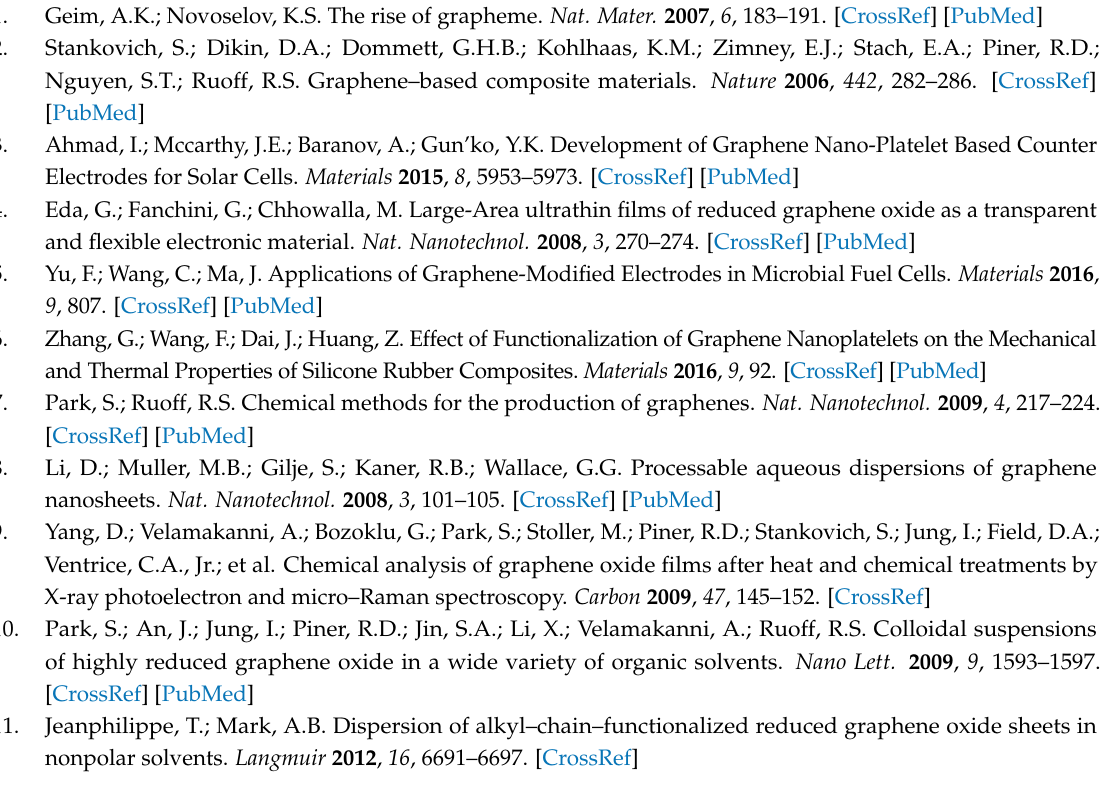
s1, Figure S1: The characterization of original material of GO (from left to right: XRD of GO; TEM of GO and AFM of GO), Figure S2: FTIR spectrum of ODA, Figure S3: TG of GO and RGO (35 ◦ C, 0.5 h), Figure S4: AFM and digital picture of ORGO (35 ◦ C, 0.5 h), Figure S5: Deconvolution of the peaks curves of C 1s and N 1s spectrum of ORGO created at 35 ◦ C for 24 h, Figure S6: Deconvolution of the peaks curves of C 1s spectrum of HRGO (labelled j) created at 80 ◦ C for 5 h, Table S1: Hansen Solubility Parameters for Various